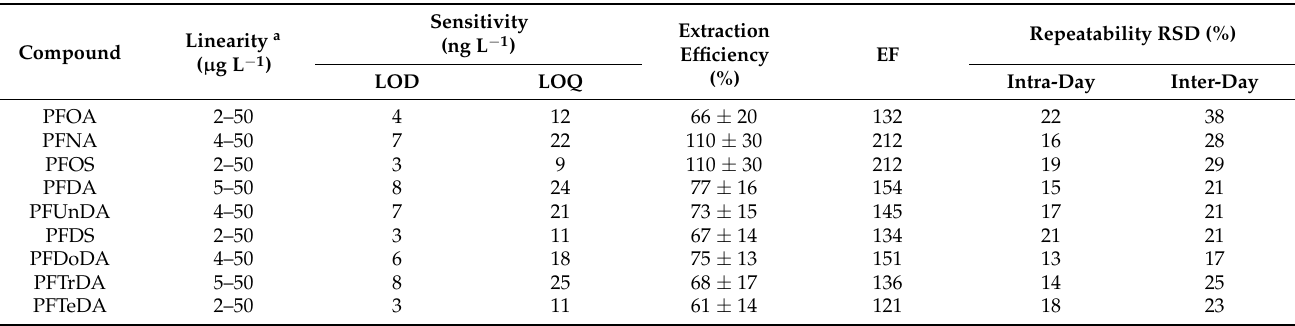
Table 2. Analytical figures of merit of the developed SPE-UHPLC-MS/MS method for C 8 –C 14 PFASs from water samples.